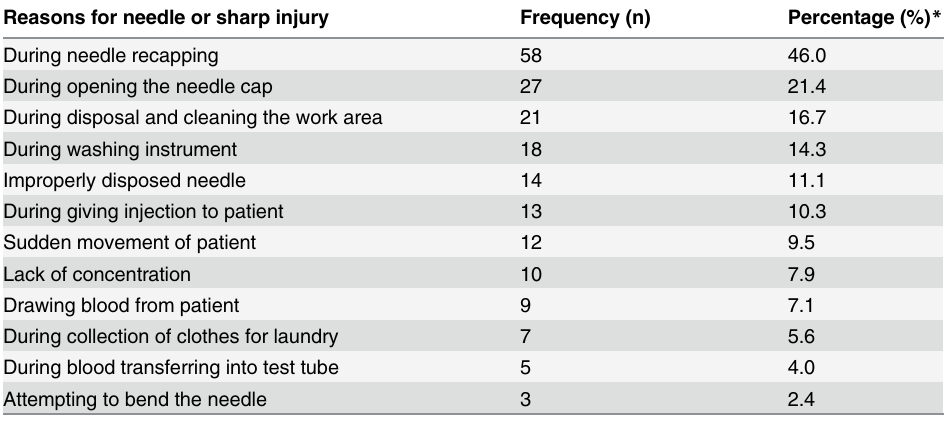
Table 2. Circumstances in which needle stick and sharps injury occurrence among hospital workers in Bale zone, December, 2014 (n = 126). Reasons for needle or sharp